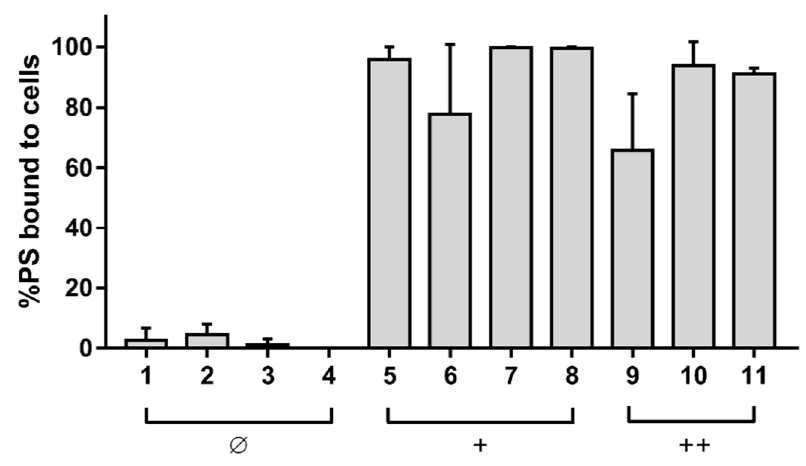
Figure 3. Evaluation of porphyrins binding to Candida albicans cells, presented as a percentage of PS bound to cells upon 1 h of dark incubation of the porphyrins ( 1–11 ) and yeast cells. The neutral (Ø), monocationic ( + ), and dicationic ( ++ ) porphyrins were administered at a concentration of 30 µM.